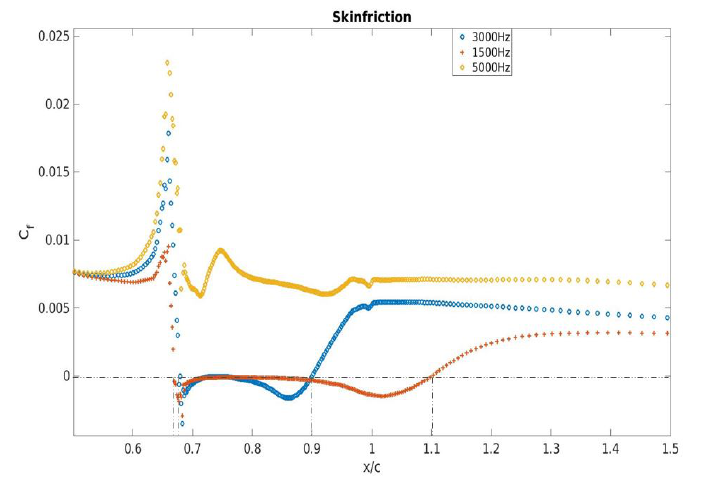
Figure 22. Coefficient of skin friction comparisons for different voltage